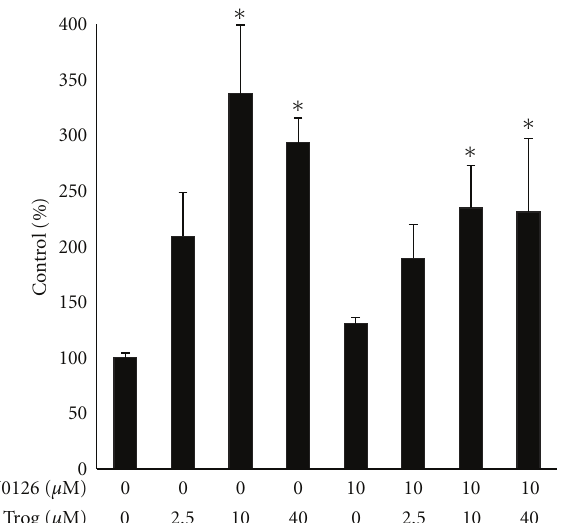
Figure 4: U0126 does not alter the transcriptional activity of PPAR γ in prostate cancer cells. PC-3 cells were plated in 6-wells plates and transfected with the PPRE-luciferase and CMV β -galactosidase reporter plasmids. The transfected cells were then treated for twenty-four hours with DMSO vehicle or troglitazone (2.5–40 μ M) in the presence or absence of 10 μ M U0126. Luciferase activity in treated cells was measured and normalized to β -galactosidase activity. Each bar represents the mean ± SD for three wells. ∗ P < 0 . 05 compared to vehicle control (0 μ M U0126, 0 μ M troglitazone). At each concentration of troglitazone tested, there was no statis- tically significant di ff erence noted between the troglitazone and troglitazone + U0126 groups. A representative experiment is shown.